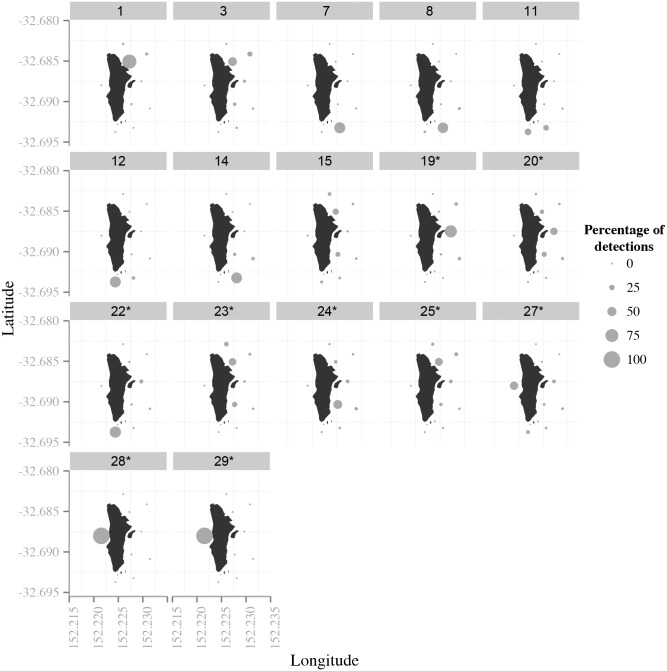
Bubble plots showing the percentage of detections at each receiver for those fish considered to be resident fish around Cabbage Tree Island (fish that were detected > 65% of available half hour time bins).* indicates adult fish.